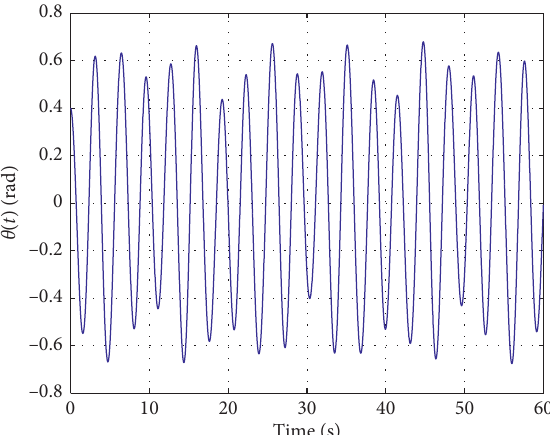
Figure 4: Attitude angle of the spacecraft without